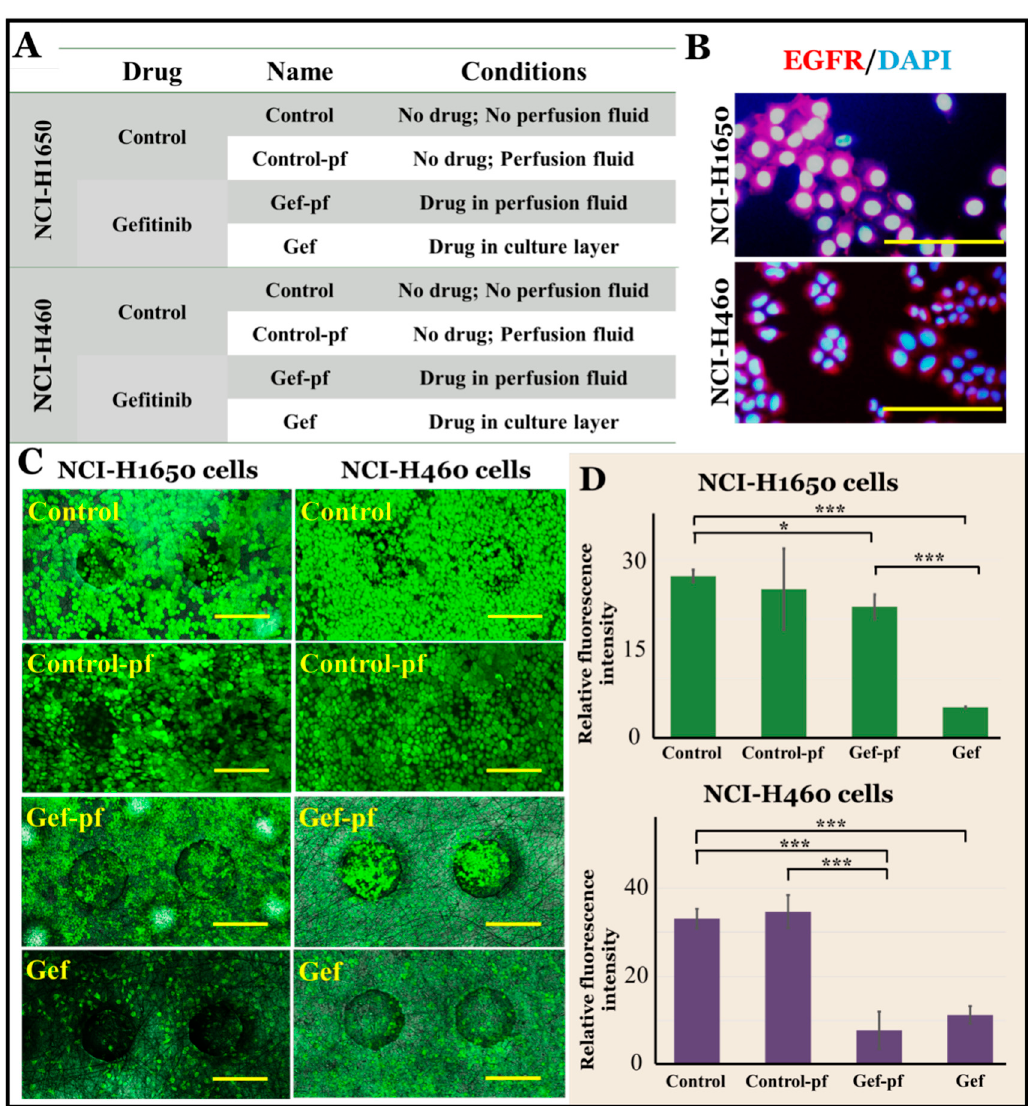
Figure 5. ( A ) Grouping and labeling of NCI-H1650 cells and NCI-H460 cells drug evaluations under normoxic condition. ( B ) EGFR expression of NCI-H1650 cells and NCI-H460 cells. EGFR: red; DAPI for cell nucleus: blue. Bar = 100 μ m. ( C ) Calcein-AM fluorescence image of NCI-H1650 cells and NCI-H460 cells in different groups under normoxic condition. calcein-AM: green. Bar = 200 μ m. ( D ) Histogram of the average relative fluorescence intensity of calcein-AM staining of NCI-H1650 cells and NCI-H460 cells in different groups under normoxic condition. The standard errors were obtained from Student’s t-test. n = 4; *** p < 0.005; * p < 0.05.